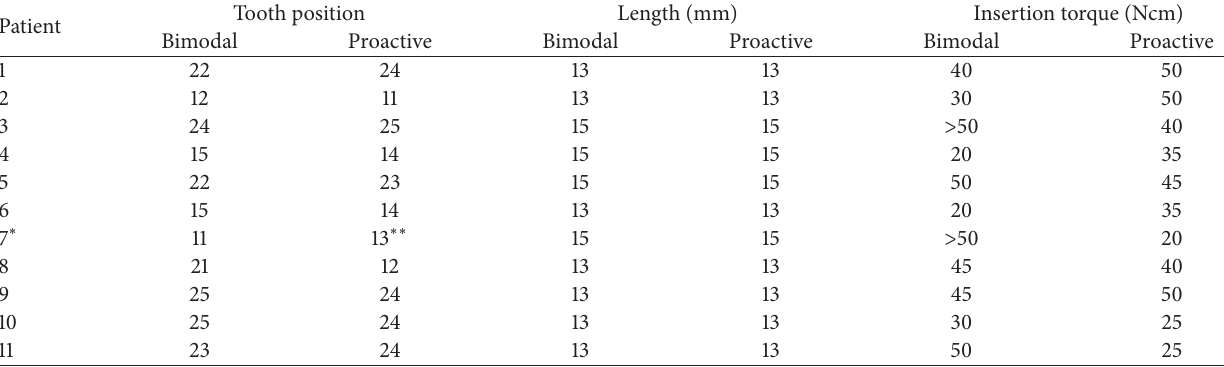
Table 1: Implant type, tooth position, length, and insertion torque for each